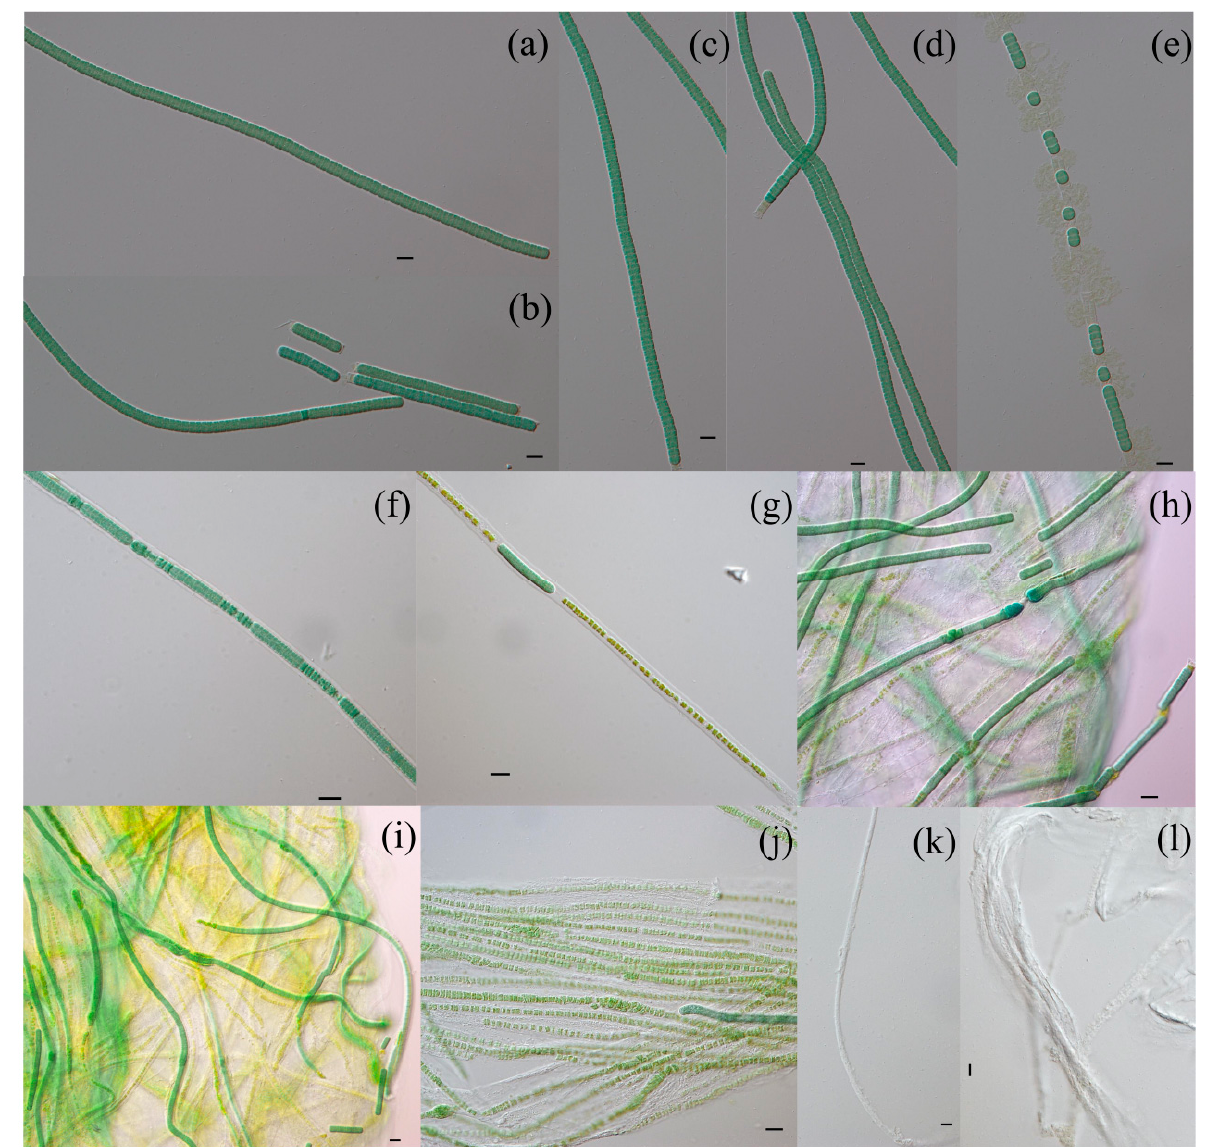
Figure 1. Light microscopy of Microcoleusiopsis ganfuensis strains. ( a – e ) Immature filaments without sheaths. ( f ) Immature filaments with colorless sheaths. ( g , h ) Trichome fragmentation and formation of necridia. ( i , j ) Old filaments of 3–month–old. ( k , l ) Decline filaments with lamellated sheaths. Scale bars: 10 μ m.